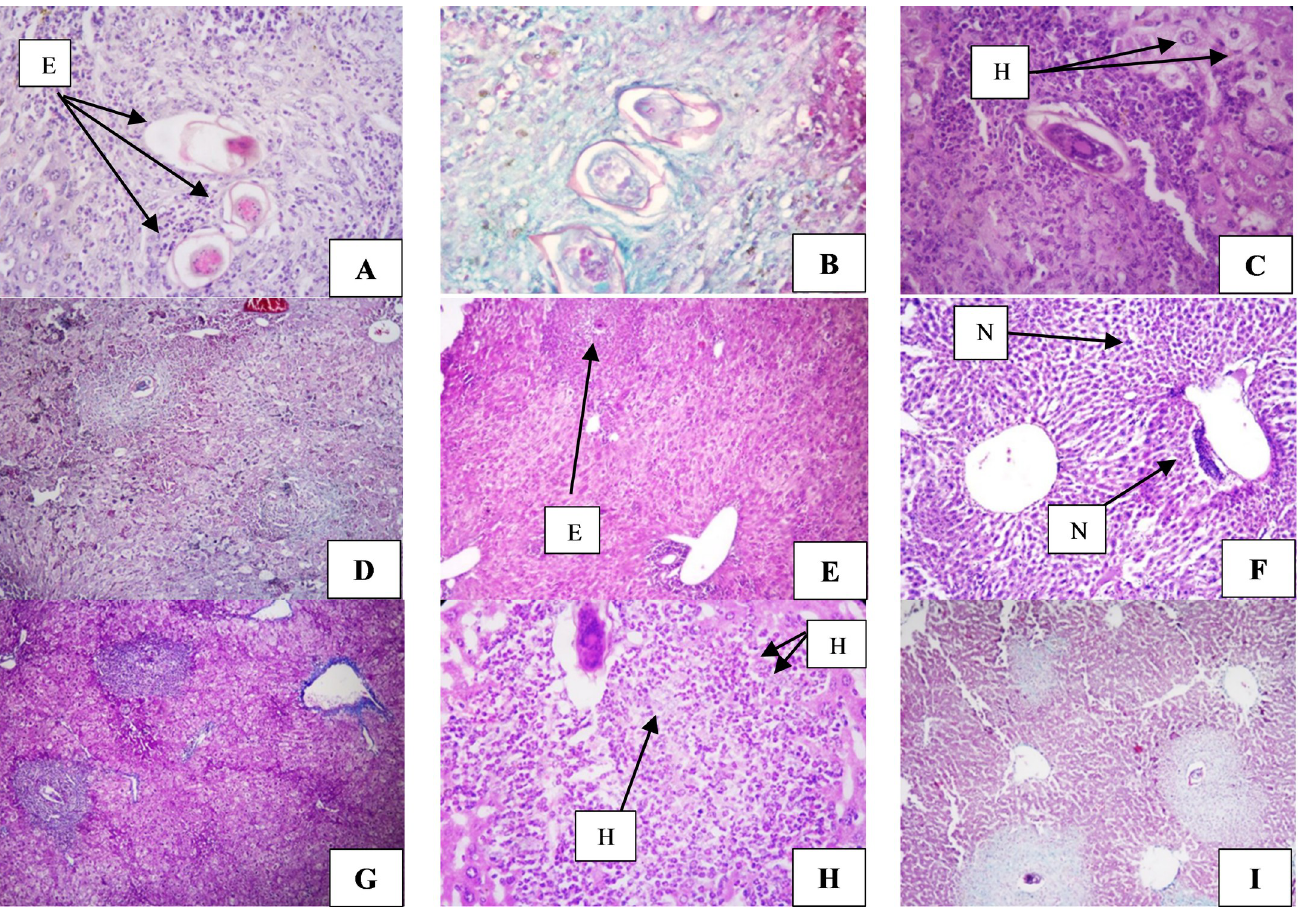
Fig 6. Histopathological findings in liver sections of infected control group (A, B), infected adjuvanted control group (C, D), infected vaccinated group (E-G) and infected vaccinated adjuvanted group (H, I). (A) H &E-stained section shows three eggs (E) surrounded by diffuse infiltrate (X400), (B) Trichrome-stained section showing fibrosis in granuloma around the eggs (X400). (C) H &E-stained section shows egg surrounded by granulomatous infiltrate formed mainly of histiocytes (H) (X400), (D) Trichrome-stained section showing fibrosis around the eggs. (X100). (E) H & E-stained liver section shows few eggs (E) surrounded by granulomatous reaction (X100), (F) H & E-stained liver section shows minimal infiltrate around the central vein with neutrophils infiltration (N) (X 400), (G) Trichrome -stained section showing fibrosis around the eggs with minimal fibrosis around central vein. (H) H & E-stained S . mansoni granulomatous rection formed mainly of histocytes (H) (X400), (I) Trichrome -stained section showing fibrosis around the eggs with minimal fibrosis around central vein